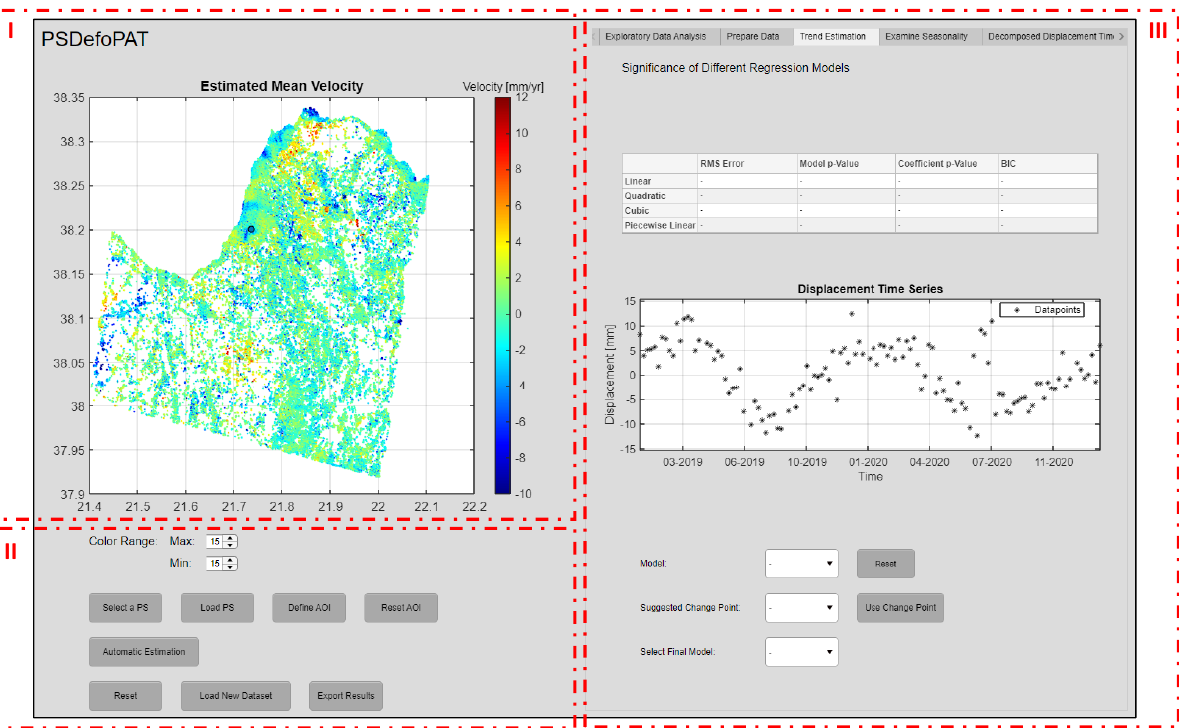
Figure 2. PSDefoPAT userinterface structured into Area I, II and